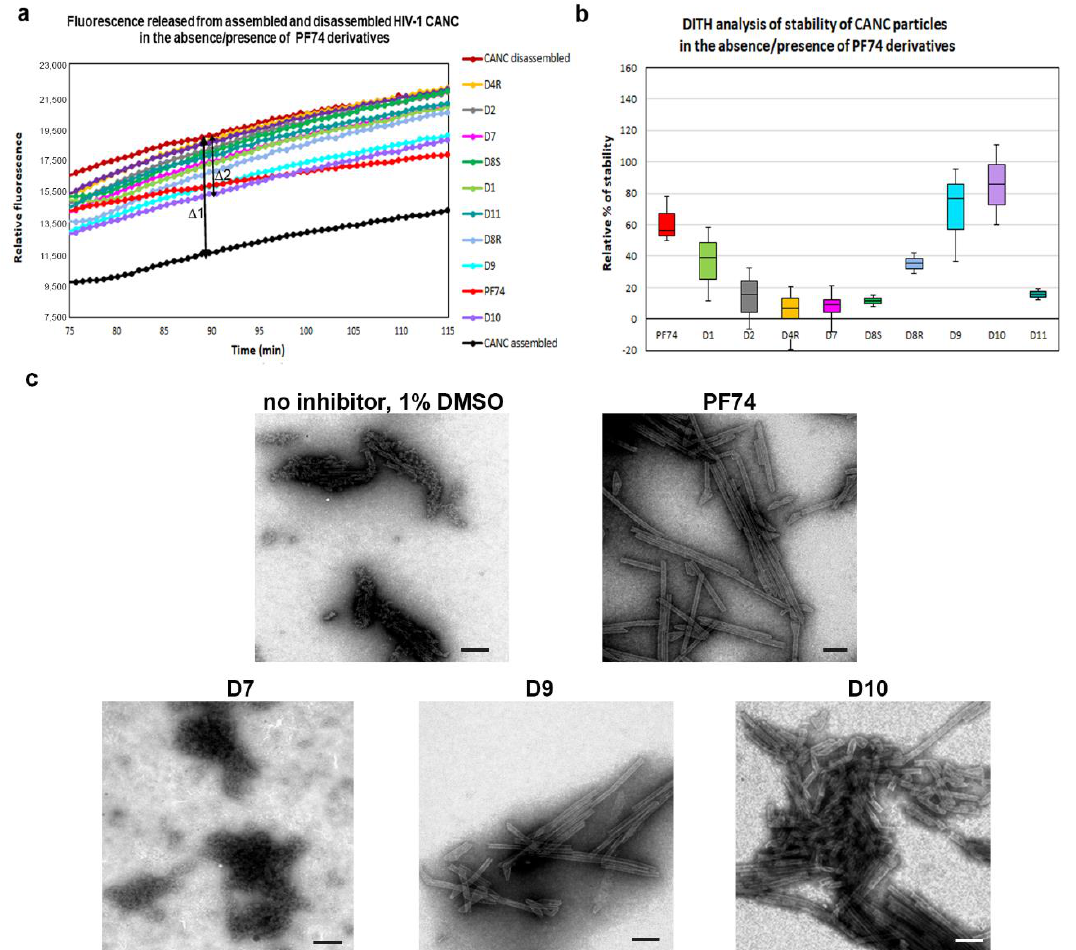
Figure 3. Disassembly inhibitor test for HIV (DITH) analysis of the effect of PF74 and its derivatives on the stability of HIV-1 CANC. ( a ) Graph showing the fluorescence emission curves demonstrating the kinetics of tqON release from preassembled CANC particles incubated in assembly buffer (black curve) and disassembly buffer (red curve) in the absence of PF74 derivatives or in the disassembly buffer containing: PF74 red, D1 light green, D2 grey, D4R yellow, D7 pink, D8S dark green, D8R light blue, D9 cyan, D10 violet, and D11 azure at the final concentration 10 µM. The stabilization effect of PF74 and its derivatives was calculated as the difference between the relative fluorescence of tqON at 90 min in the disassembly and assembly reactions according to the calculation: relative percent of stabilization = 100*Δ2/Δ1. ( b ) DITH quantification of the relative stability of preassembled CANC particles incubated in the disassembly buffer in the presence of PF74 and its derivatives, measured and calculated as described in ( a ). The relative stability of CANC in the absence of inhibitor in disassembly buffer was considered as 0%. ( c ) Following DITH, the in vitro assembled HIV-1 CANC in the presence of indicated inhibitors were incubated in disassembly buffer, negatively stained, and analyzed by TEM. Bar represents 200 nm.